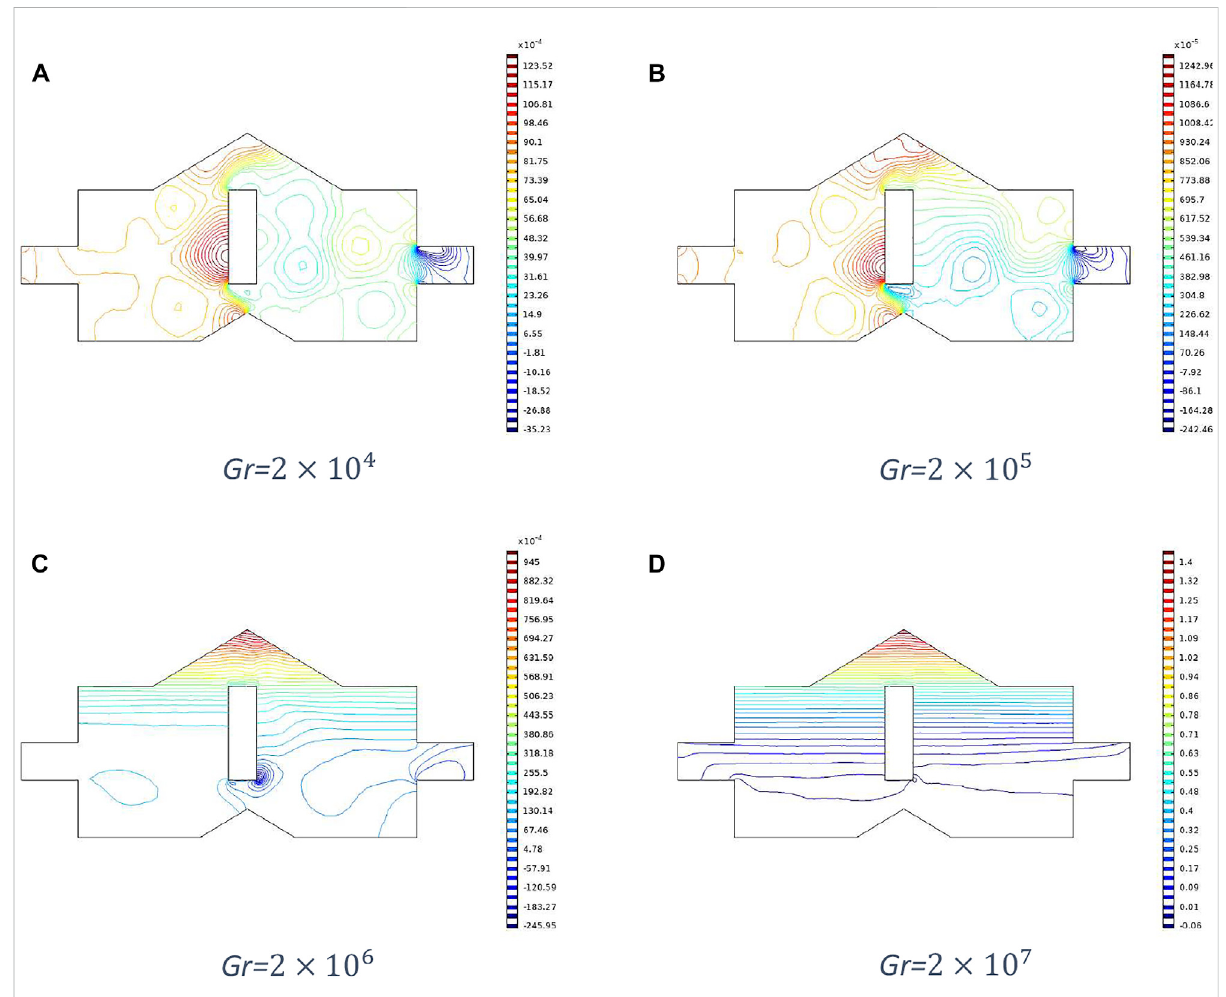
FIGURE 6 Pressure Variation at Re = 1,000 and at different Grashof